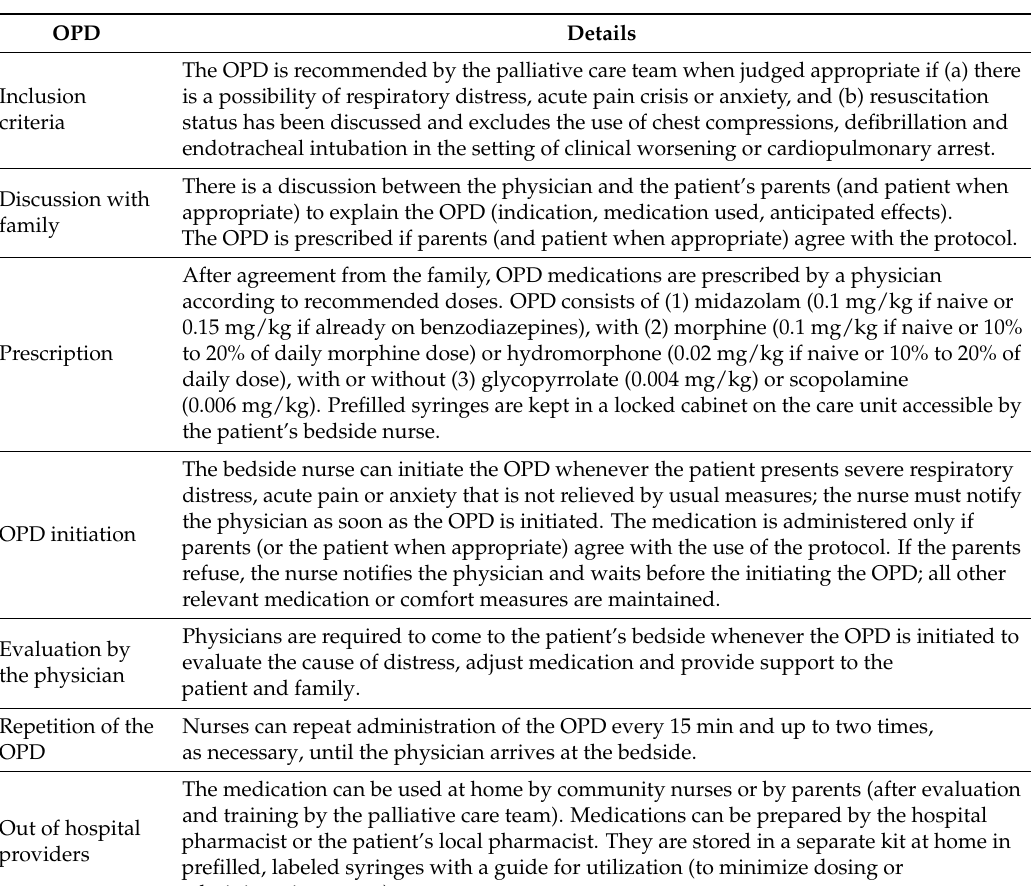
Table 1. Details of the Order Protocol for Distress